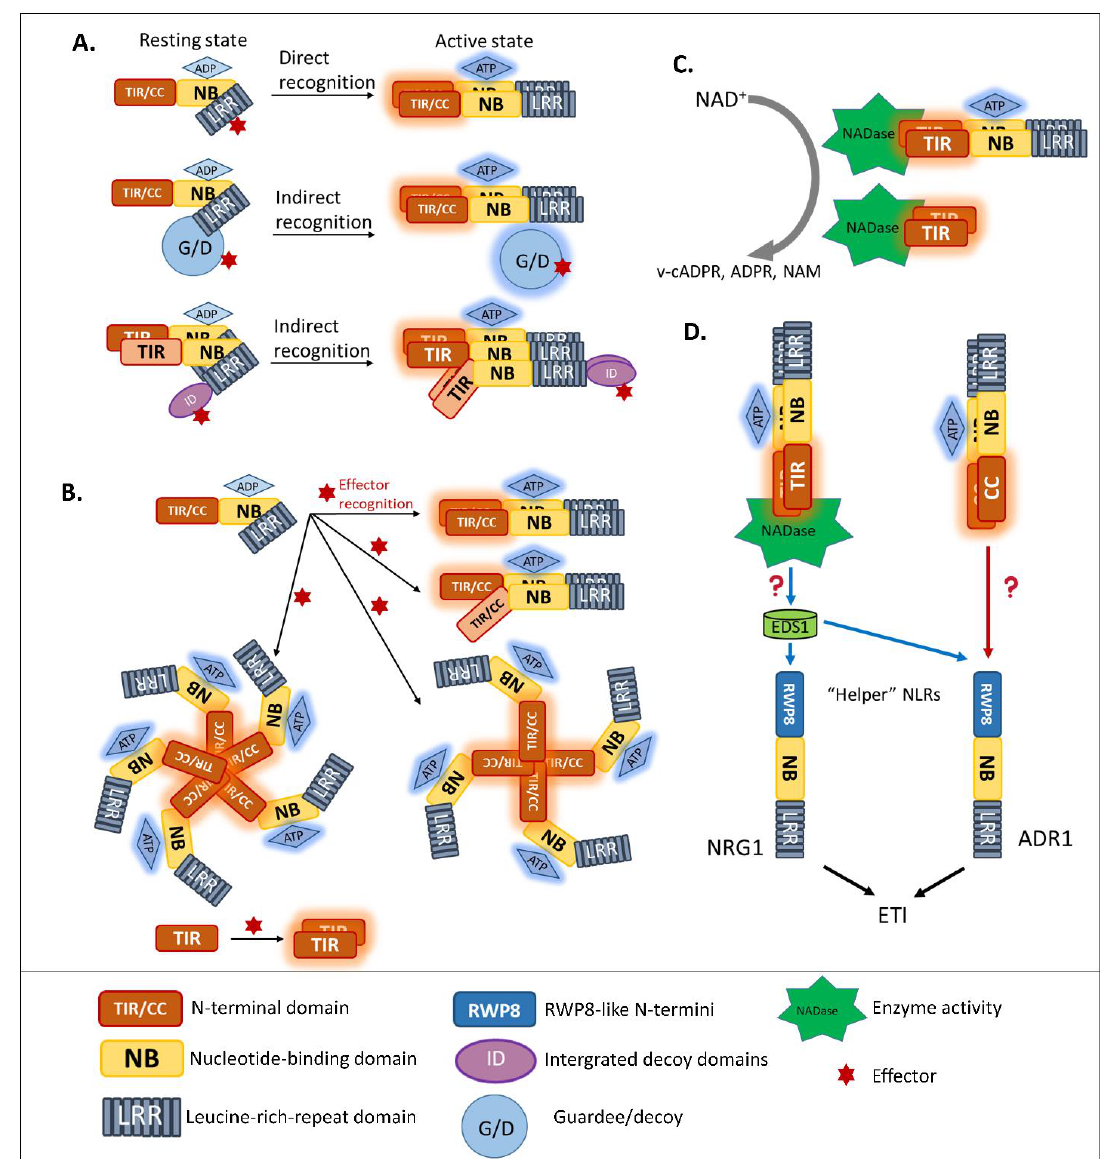
Figure 2. Diverse roles of nucleotide-binding and leucine-rich-repeat-containing receptors (NLRs) in immune signaling. ( A ) The evolution of NLR effector recognition systems. A common NLR consists of a diverse N-terminal domain, a central nucleotide-binding (NB) domain, and a C-terminal leucine-rich repeat (LRR) domain. NLRs are classified into two groups, depending on the N-terminus—toll interleukin-1-receptor (TIR) NLR (TNL) and coiled-coil (CC) NLR (CNL). NLRs recognize pathogen effectors directly through the LRR domain or indirectly through a host guardee/decoy protein. During coevolution, some NLRs acquired unusual integrated decoy (ID) domains for pathogen recognition. ( B ) The molecular switch of NLRs during effector recognition leads to NLR homo/hetero/oligomerization (the NLR “resistosome”). In response to pathogen effectors, the open-lid form of NLRs is formed. ADP–ATP exchange occurs, leading to NLR activation. The associations of NLRs, such as homodimerization, heterodimerization, and oligomerization, are important for downstream signaling. ( C ) After the formation of an NLR resistosome, the enzymatic activity of plant TIR produces nicotinamide adenine dinucleotide (NAD) derivatives. ( D ) Downstream components, ENHANCED DISEASE SUSCEPTIBILITY 1 (EDS1) and “helper NLRs” (N REQUIREMENT GENE 1 (NRG1) and ACTIVATED DISEASE RESISTANCE PROTEIN 1 (ADR1)), are required for NLR signaling. While CNLs depend on helper ADR1 to function (indicated by red arrow), TNLs activate NADase and require EDS1 (indicated by blue arrows) and both helpers (ADR1 and NRG1) for signal transduction. NRG1 and ADR1 mediate effector-triggered immunity (ETI) (indicated by black arrows). Question marks indicate the unknown mechanisms in NLR-triggered